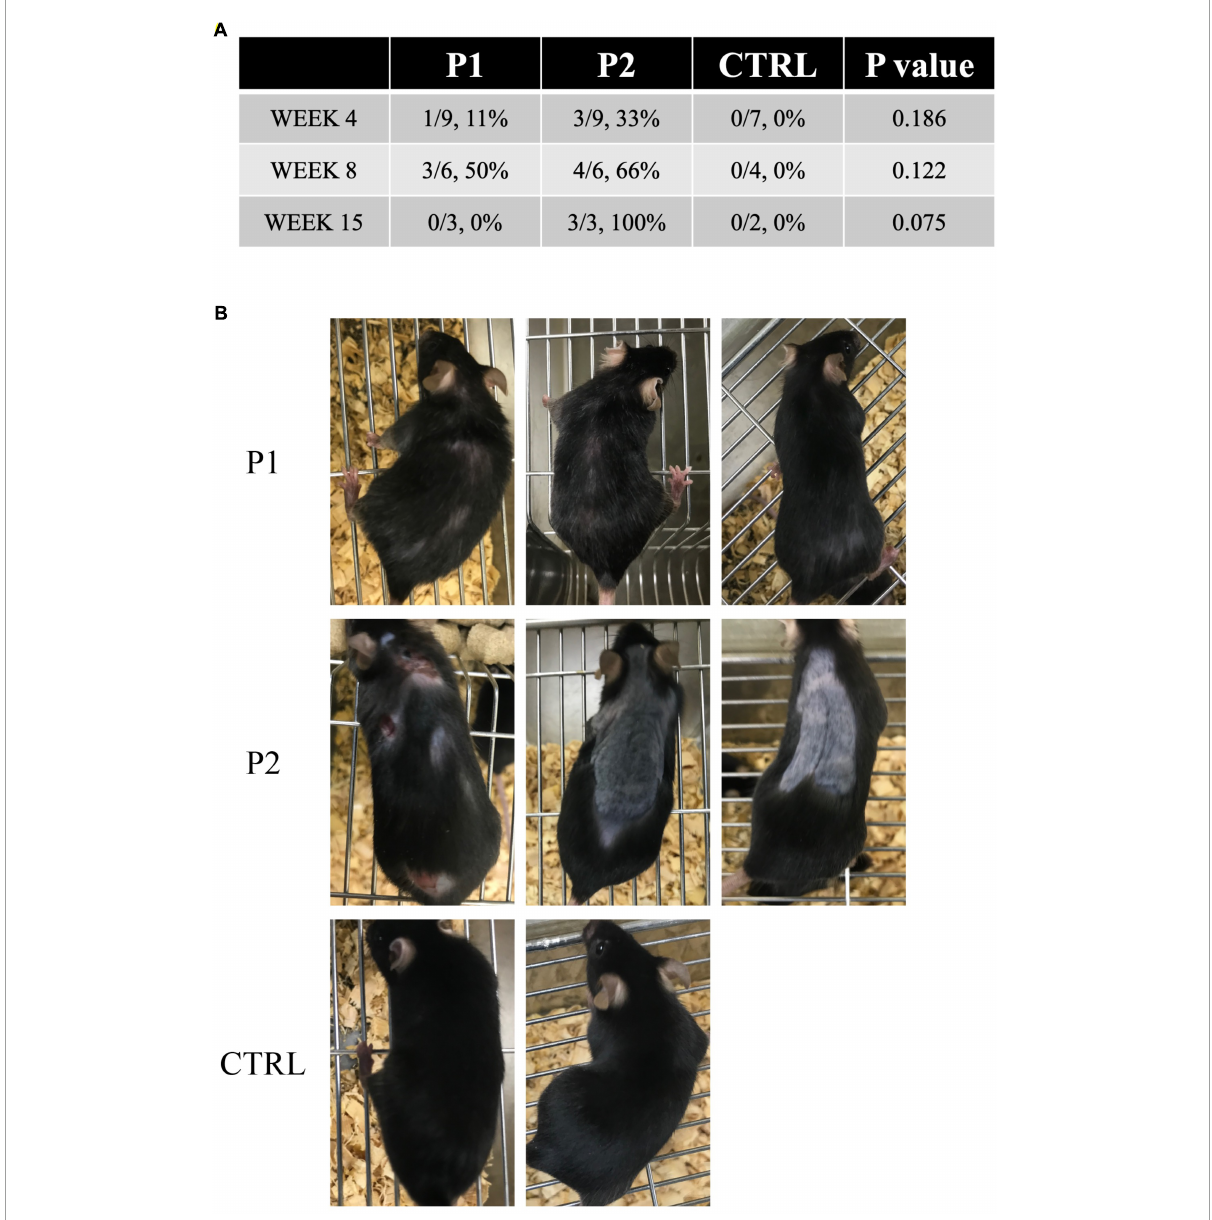
FIGURE3 Skin lesions in immunized mice. (A) Prevalence of skin lesions in each group at each time point. (B) All mice at week 15. In P2 immunized mice, skin ulcers and alopecia were observed on the back of one mouse, whereas the other two mice exhibited considerable alopecia of the back.